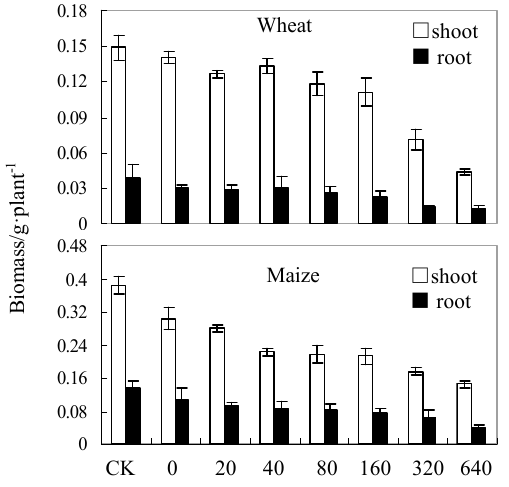
Figure 1. Biomass of wheat and maize grown in Cd-contaminated soil at various concentrations of added Pb. CK represents the control group.